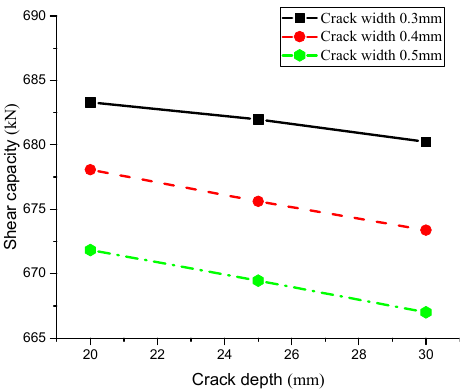
Figure 11. Relationship between crack depth and shear capacity.